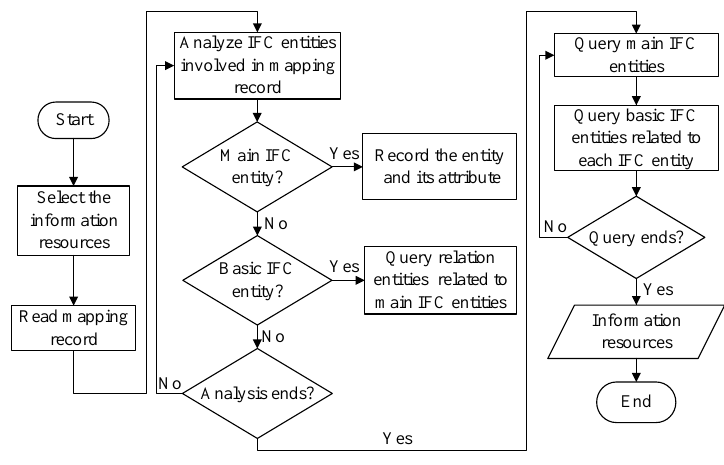
Figure 5 The process of obtaining the data of information resources (Lu